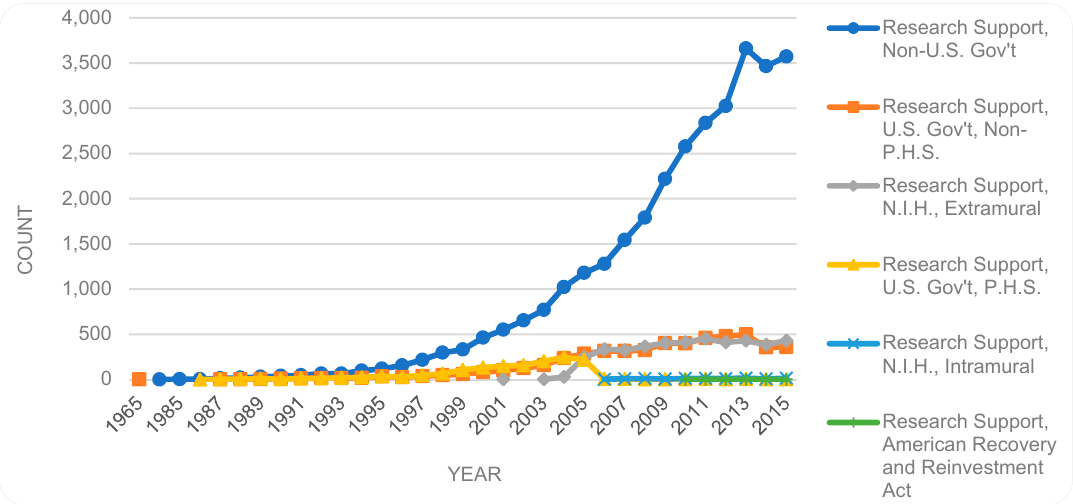
Figure 7. Support types and their trends over the years.